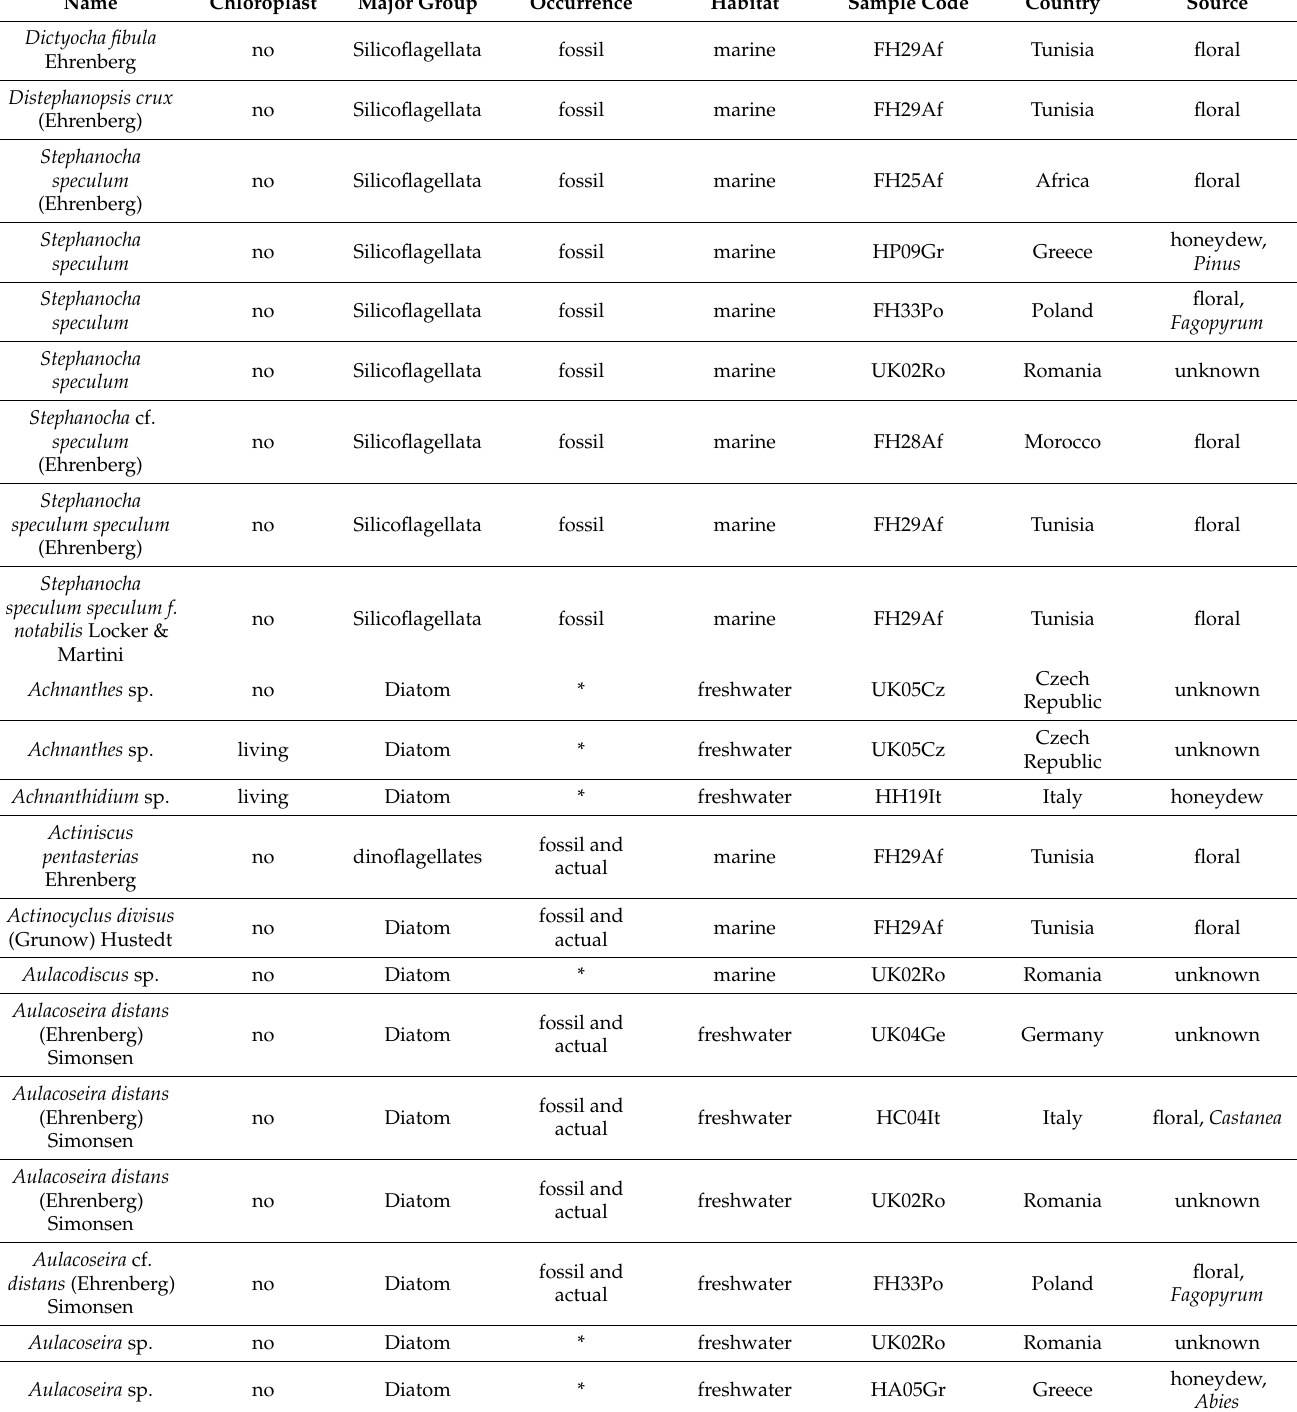
Table 1. Silicoflagellates, diatoms, and cyanobacteria found in honey